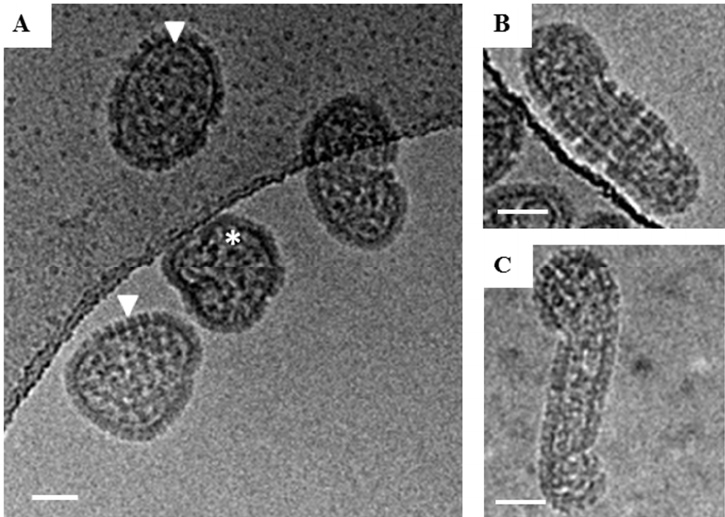
Figure 1. Cryo-EM images of glutaraldehyde-fixed HTNV particles. Examples of the three classes of virions observed in Holey Carbon grids by cryo-EM are presented. ( A ) Examples of round HTNV particles are indicated by a white triangle. The Asterix denotes an irregular shaped, crumpled ball.